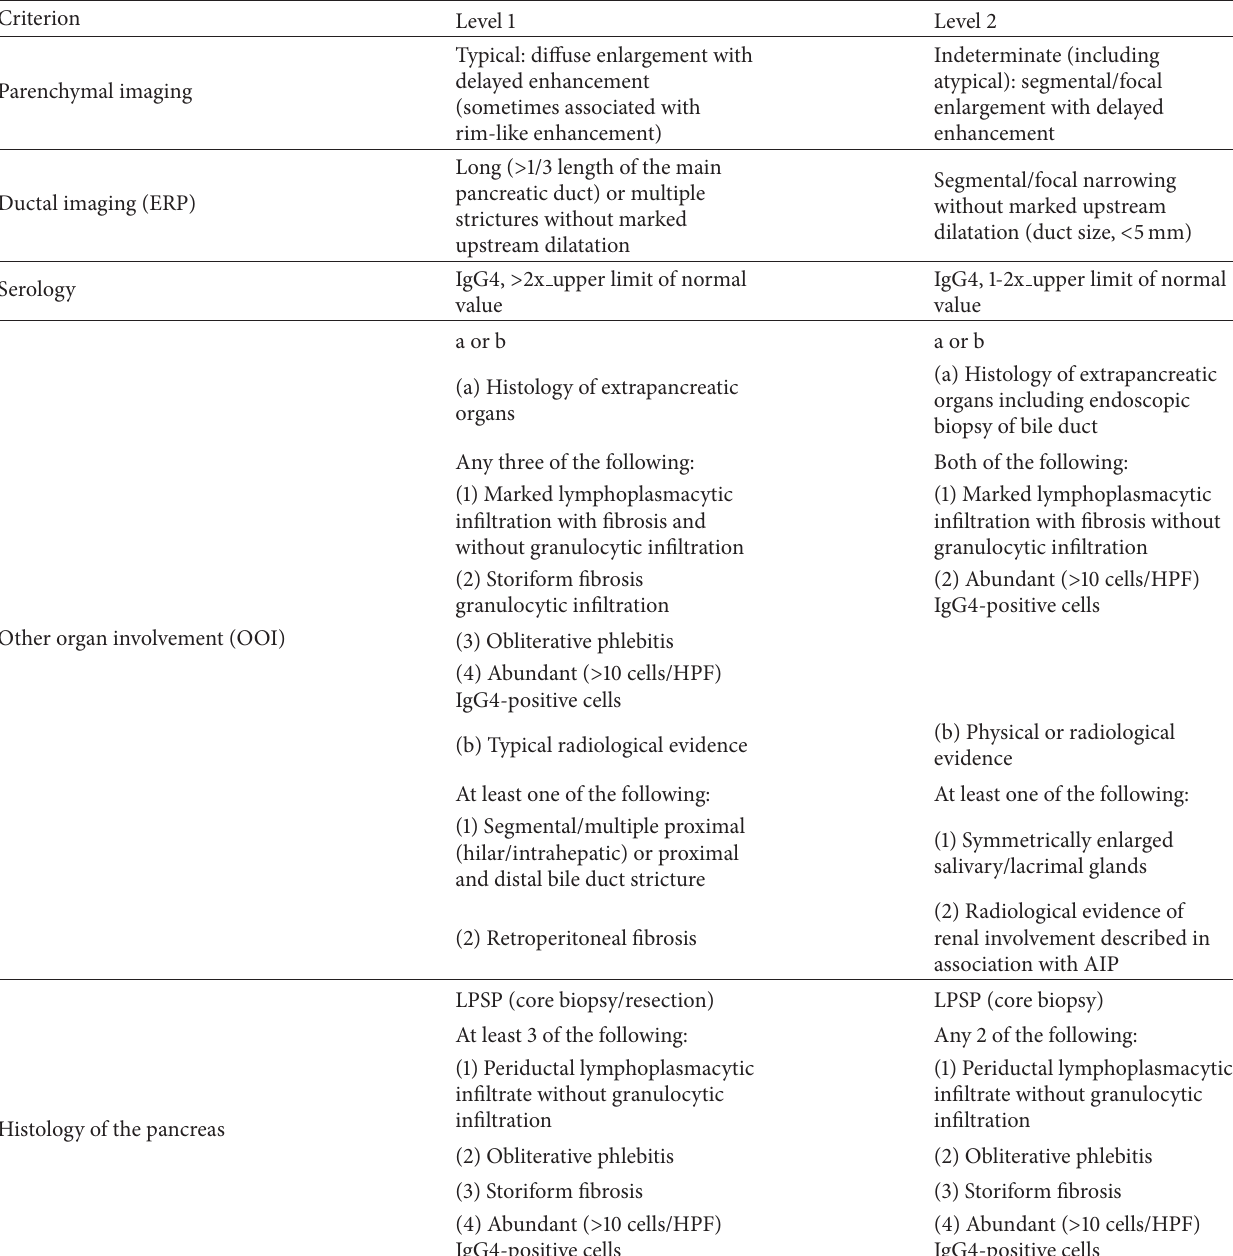
Table 1: Level 1 and level 2 criteria for type 1